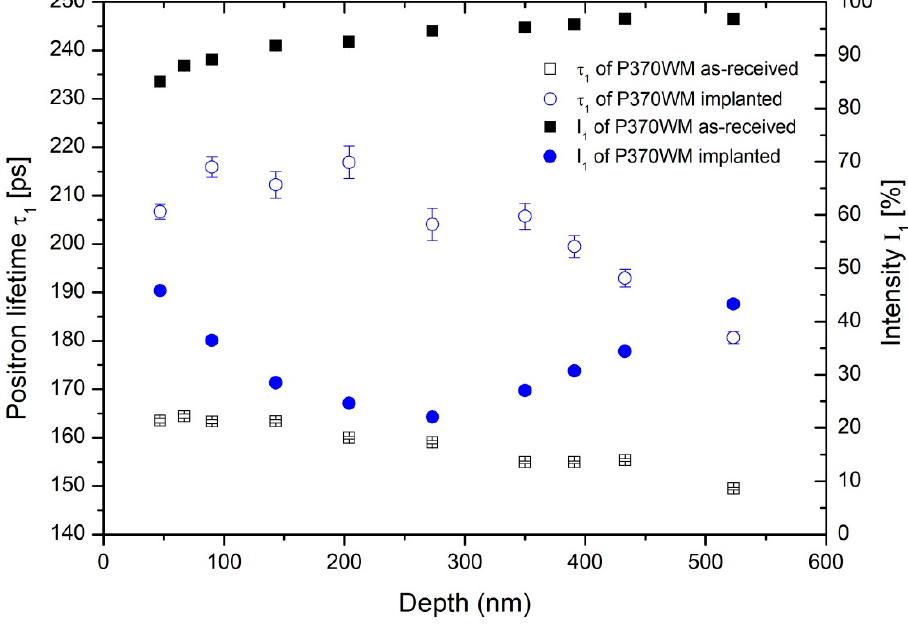
Figure 4. Comparison of PLEPS parameters in two components analyze of specimen P370 WM, before and after H + implantation by 100 keV (maximal damage at about 12 keV corresponding to depth of about 400–450 nm). Lifetimes and intensities of second component are presented. Based on this analysis, it is possible to register a small increase in the first component lifetime. This can be explained by introduction of vacancies and small vacancy agglomerations, which accompanies the initial (as-received) dislocation-type defects, characterized by this complement in